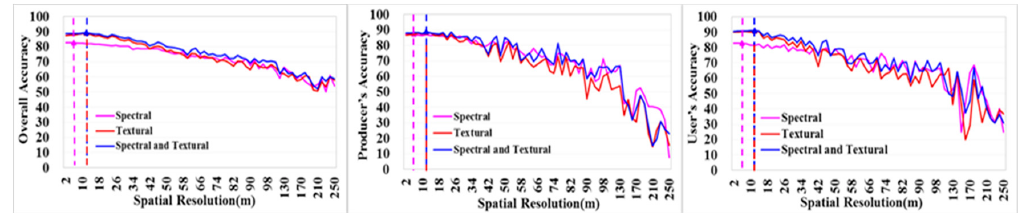
Figure 6. The variations in overall, producer's and user’s accuracies of mapping PMF in Guyuan (vertical line shows the highest accuracy of different features sets).